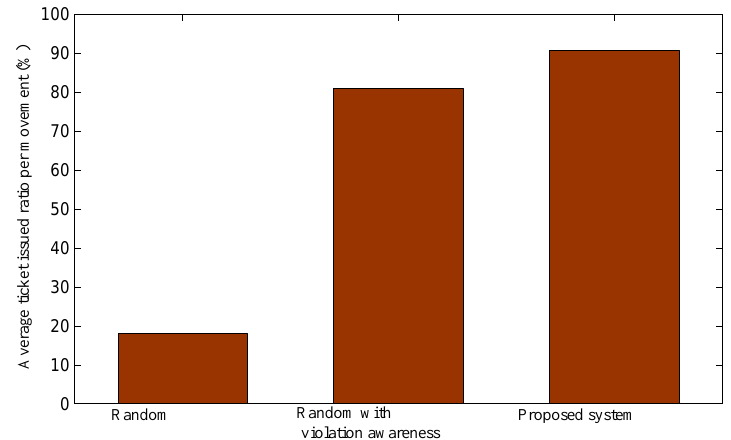
Figure 18. Average ticket issued ratio per a movement ( i.e ., from a cluster node to another cluster node) of officers in regions with low violation